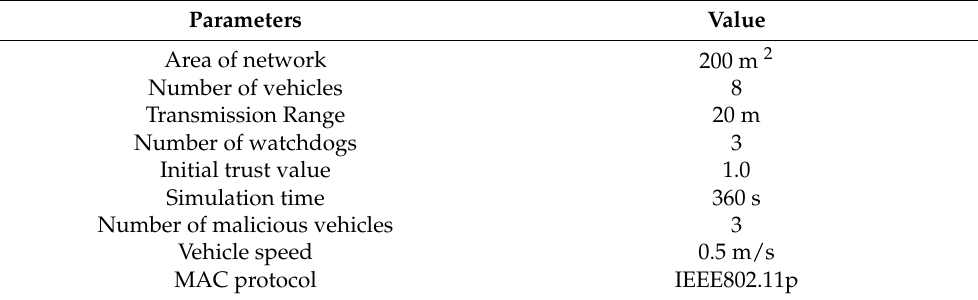
Table 2. Simulation